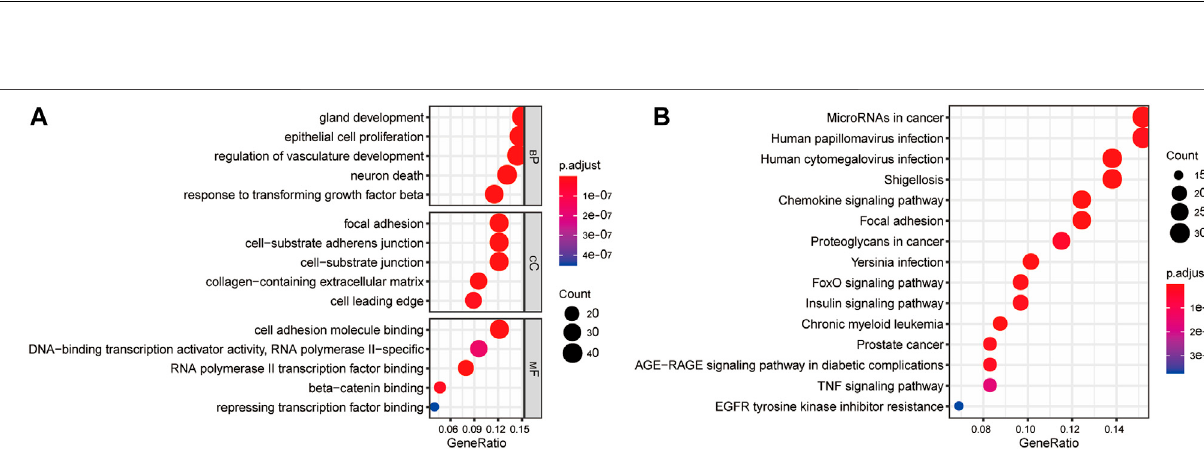
FIGURE2| Integratedanalysisofdifferentiallyexpressed EMT-correlated genes. (A) .Fourdifferentmeta-analysisalgorithms(Fisher,roP,maxP,AW)wereusedto identify differentially expressed genes in four HCC datasets. (B) Heatmap of EMT correlated-genes (FDR < 1E-19) in four HCC cohorts. (C) Veen diagram shows the differential expressed genes obtained by the four algorithms. Notes: HCC, hepatocellular carcinoma; EMT, Epithelial-mesenchymal transition.